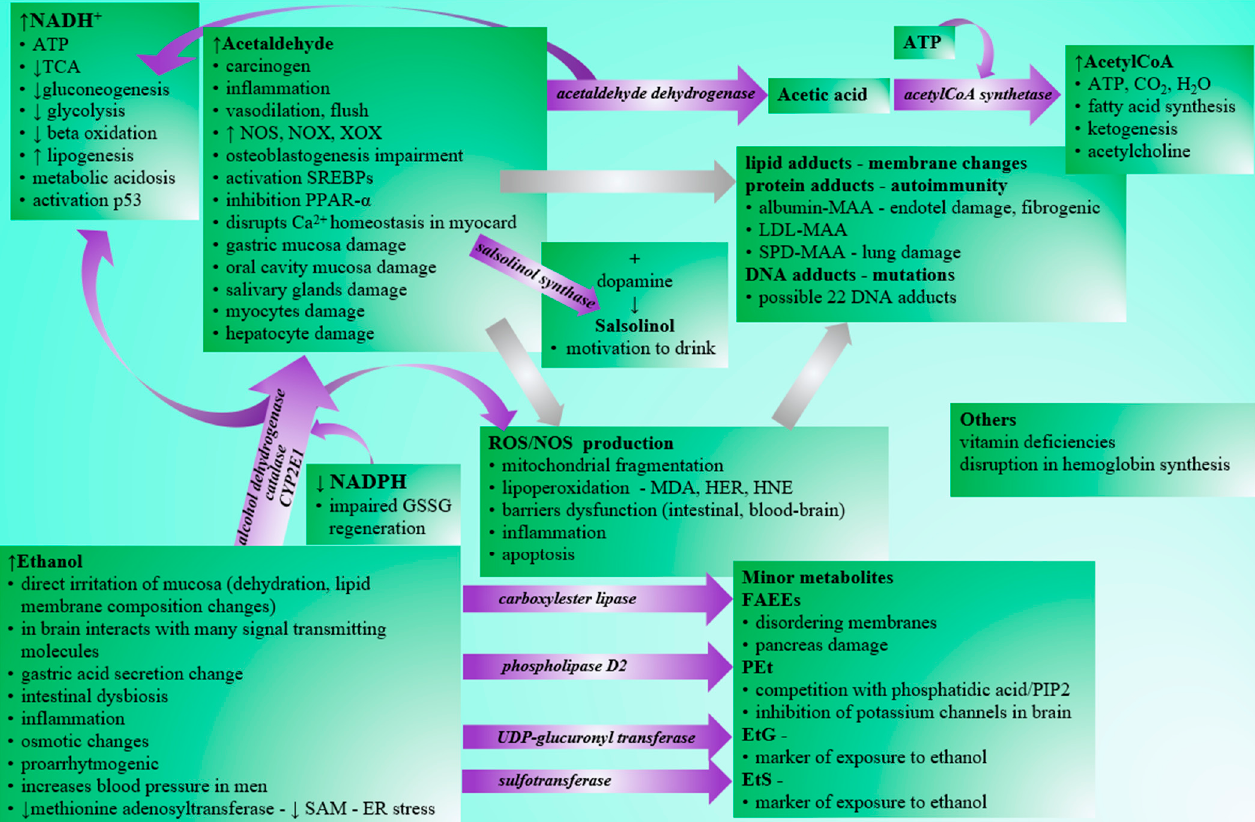
Figure 1. Pathological effects of ethanol and its metabolites. Legend: NADH—reduced nicotinamide adenine dinucleotide, ATP—adenosine triphosphate, TCA—tricarboxylic acid cycle, SAM-S—adenosyl methionine, ER—endoplasmic reticulum, NOS—NO synthase, NOX—NADPH oxidase, XOX—xanthine oxidase, GSSG—oxidized glutathione, SREBP—sterol